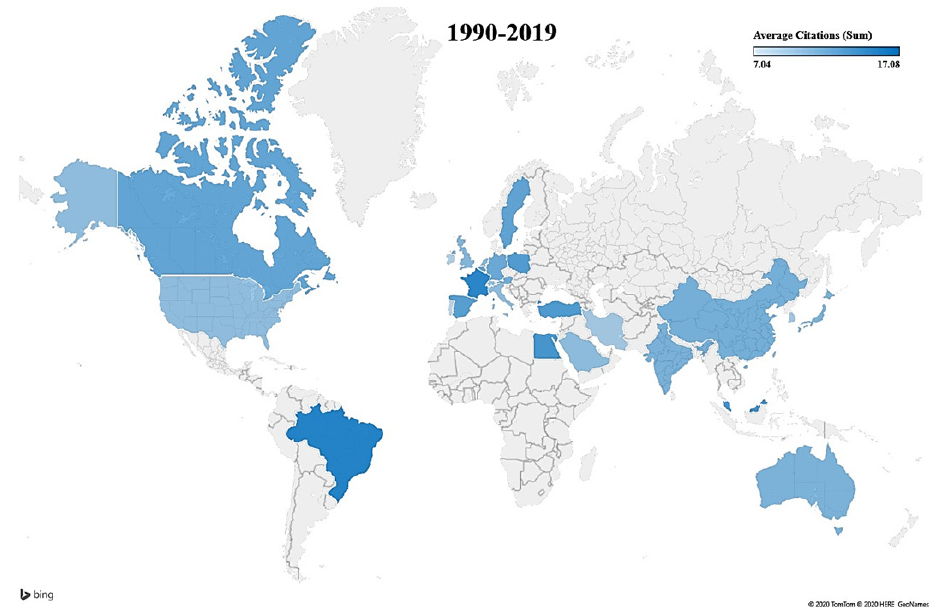
Figure 4. World map representing the averaged citations per topic set 1 related papers published 1990 through 2019. Papers may have authors from more than one country denoting international collaboration. Please refer to the color scale for averaged citations. Countries with at least 20 publications are represented.